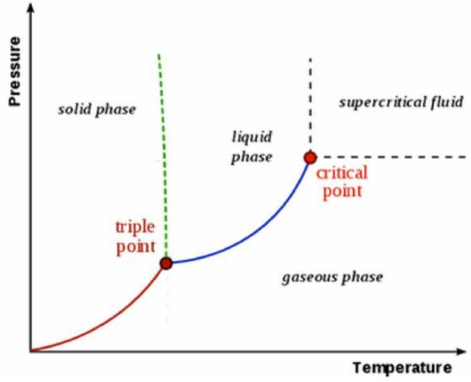
Figure 1. General phase diagram.